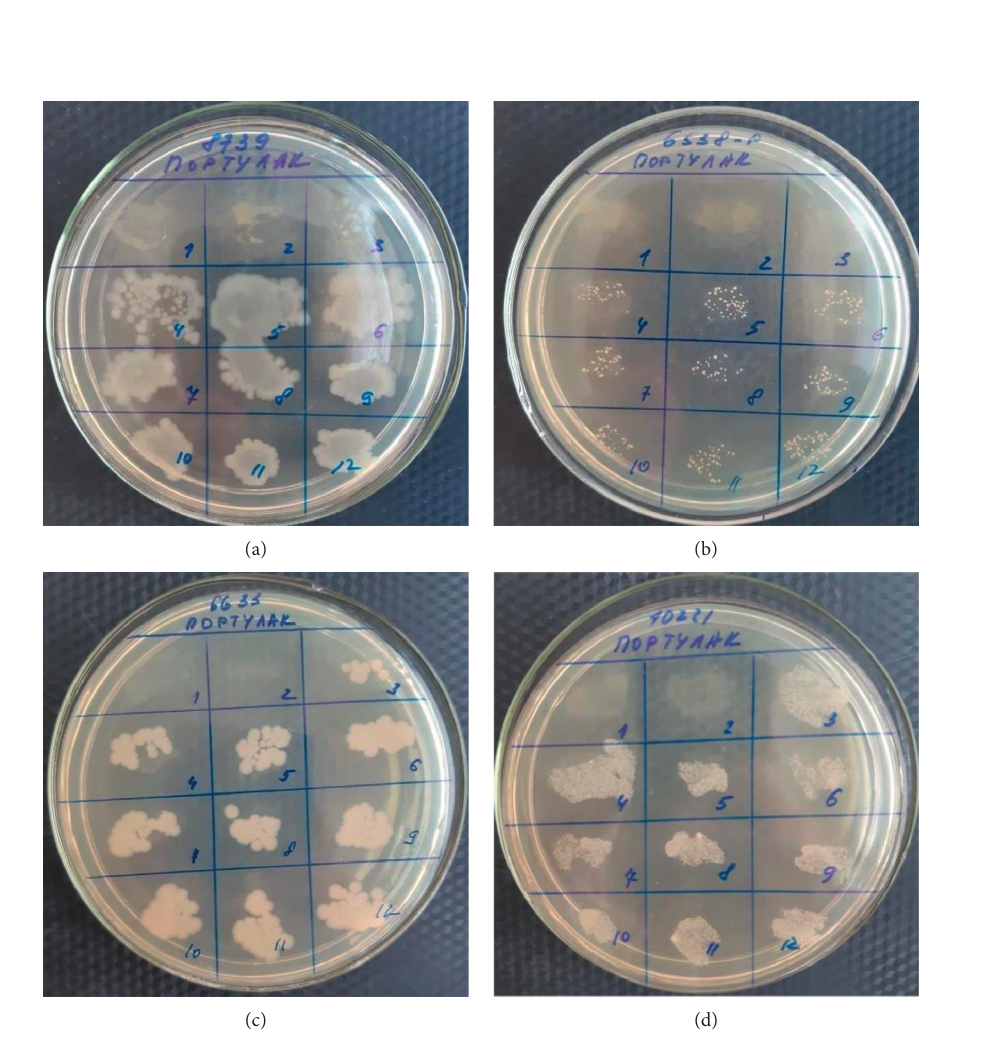
Table 5: The results of the antimicrobial activity of Portulaca oleracea ’s CO Object of investigation ( μ g/ml)